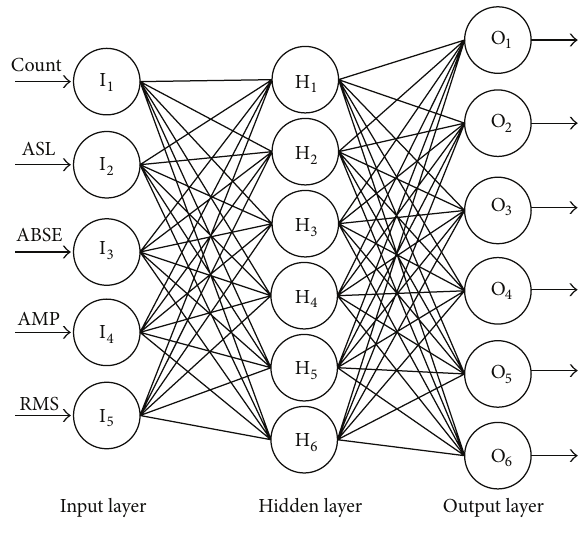
Figure 16: Artificial Neuron